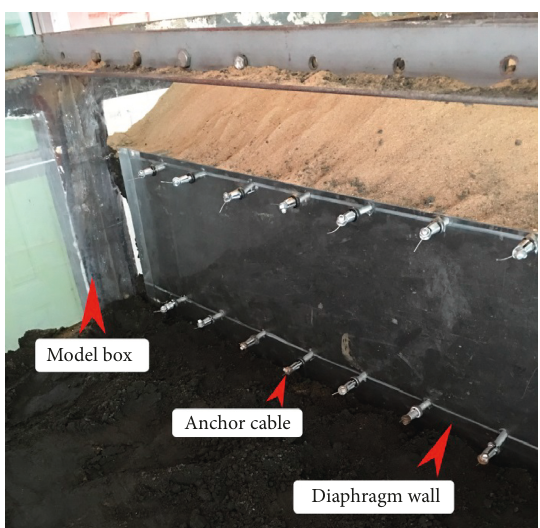
Figure 2: Excavation of the foundation pit during the model test. Figure 3: Guyed displacement sensor.